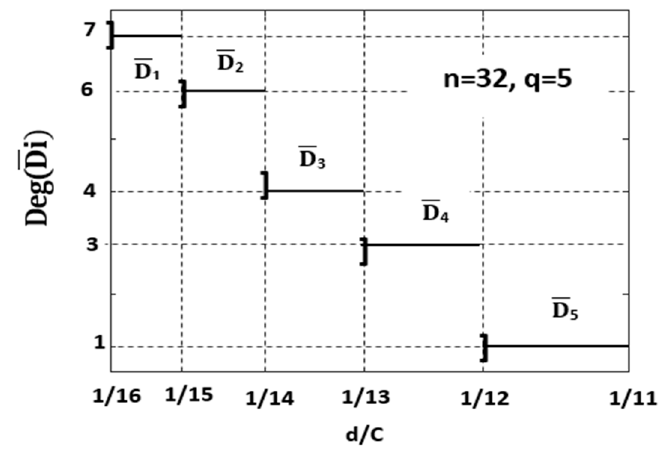
Figure A3. The variation of domain degeneracy as a function of the vaccination centres demands for selected even values of n.